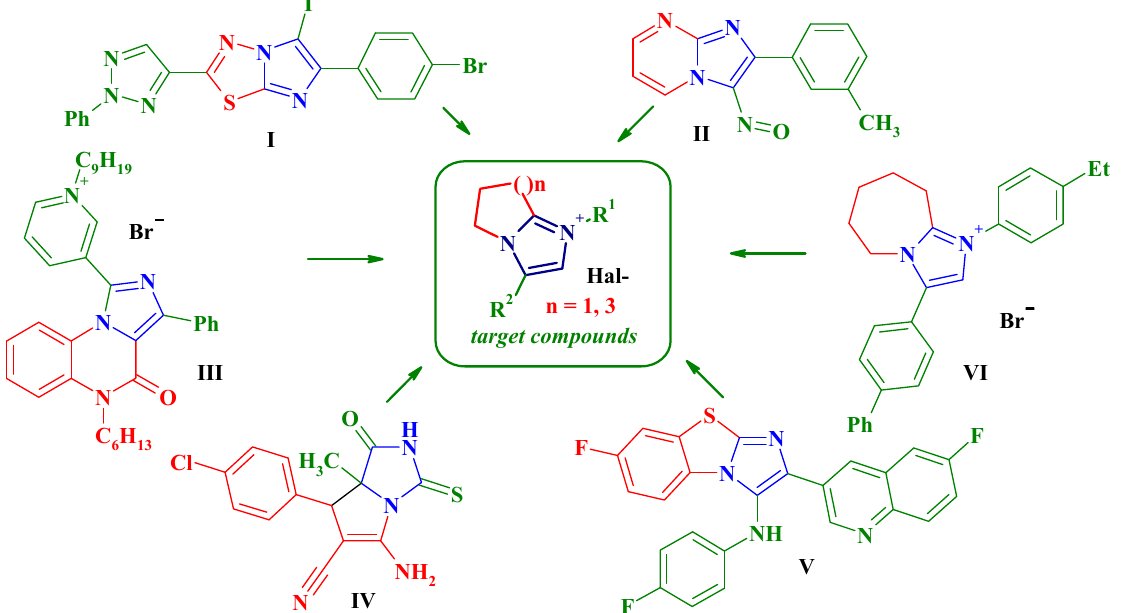
Figure 1. Background of the target compounds design.